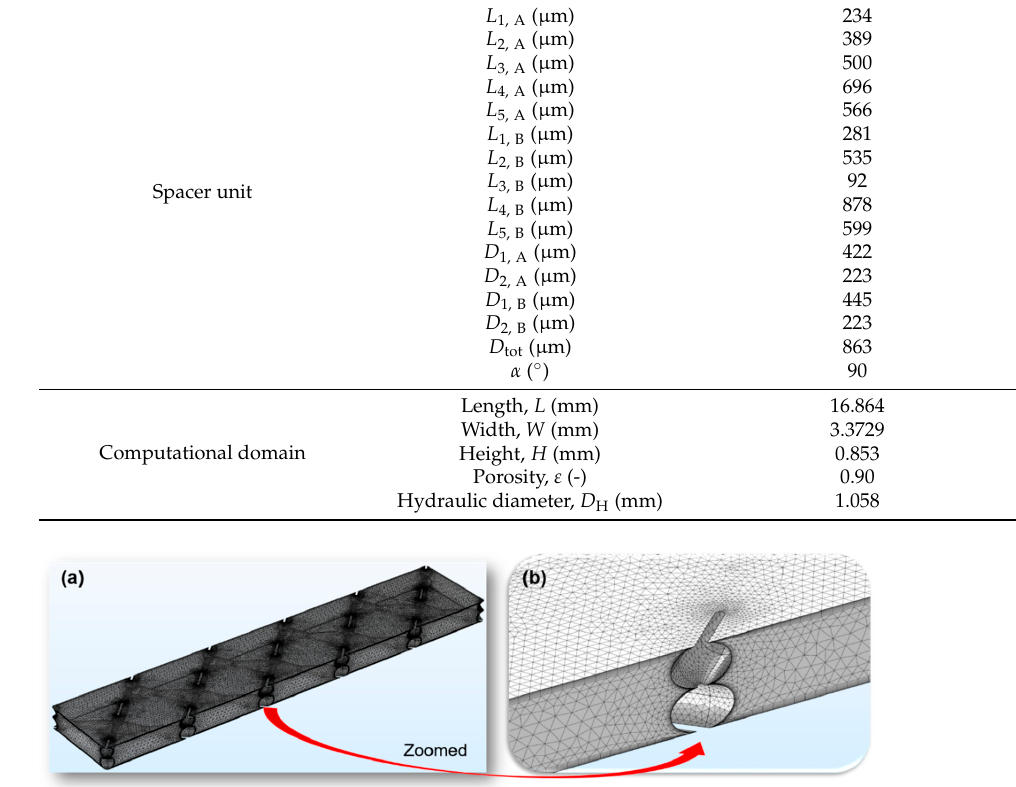
Figure 5. The water flux with inlet average velocity magnitude of 0.15 m s − 1 using the permeable wall model for ( a ) the commercial membrane ( P L = 1 L m − 2 h − 1 bar − 1 ) and ( b ) the HPM ( P L = 5 L m − 2 h − 1 bar − 1 ) systems. Figure 6. The pressure magnitude distributions with an inlet average velocity magnitude of 0.15 m s − 1 using ( a ) the permeable wall model and ( b ) the impermeable wall model.